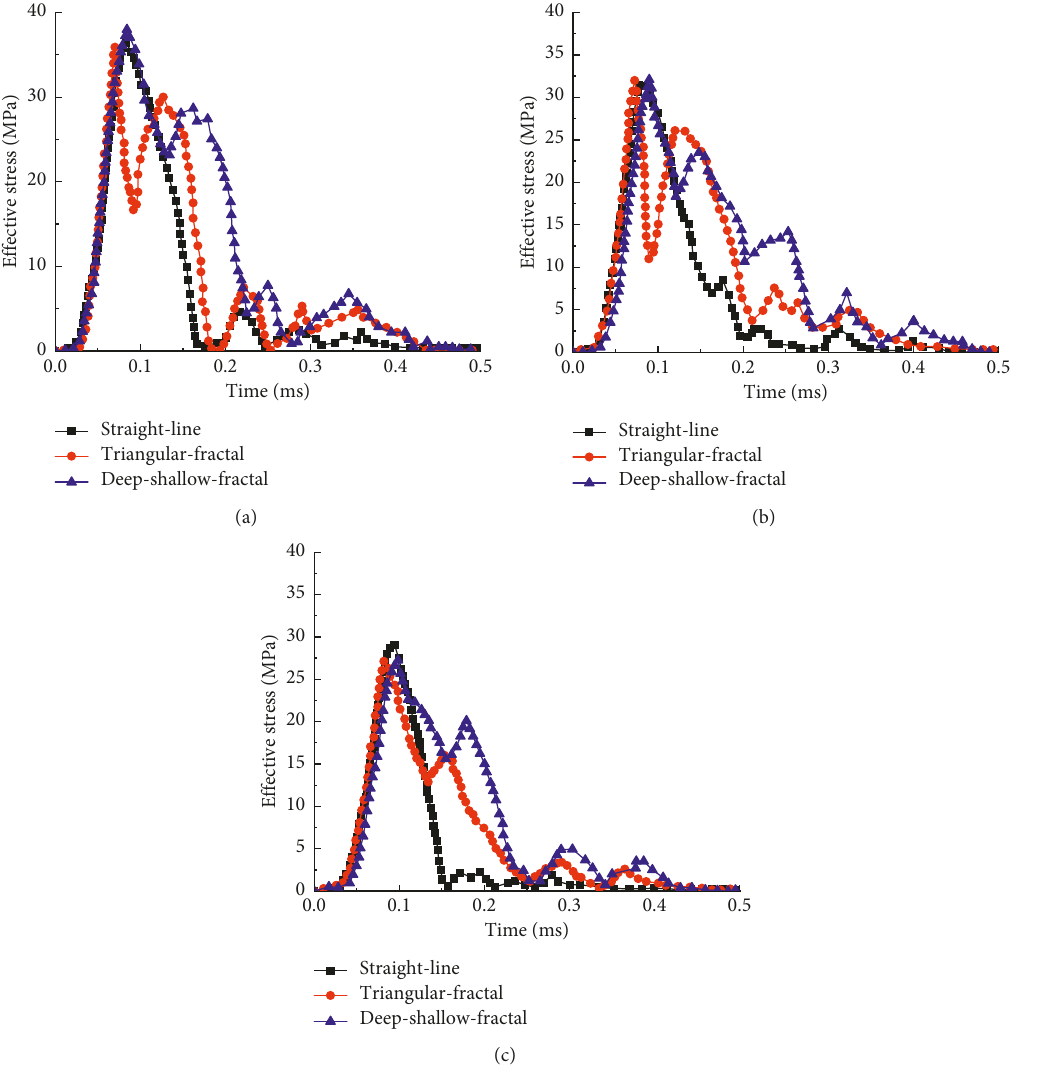
Figure 16: Variation of monitoring points of the Mises stress. (a) Monitoring point 1. (b) Monitoring point 2. (c) Monitoring point